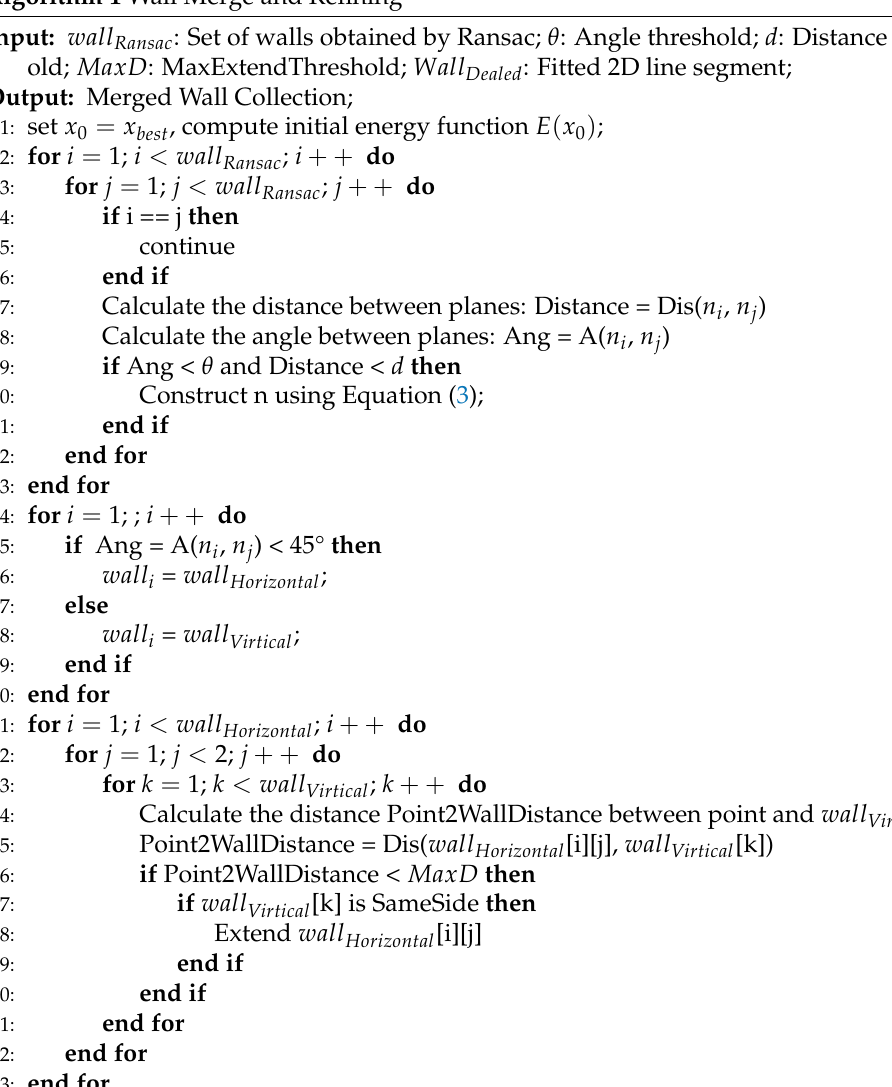
Algorithm 1 Wall Merge and